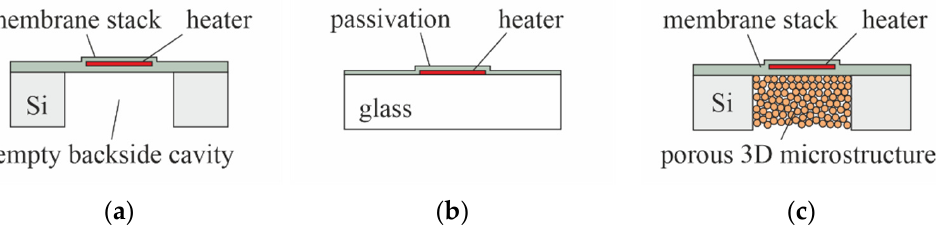
Figure 2. Test structures as fabricated on silicon or glass wafers: ( a ) heater embedded within a free- standing membrane; ( b ) heater with passivation on glass; ( c ) heater embedded within a membrane on top of a porous 3D microstructure for thermal isolation.